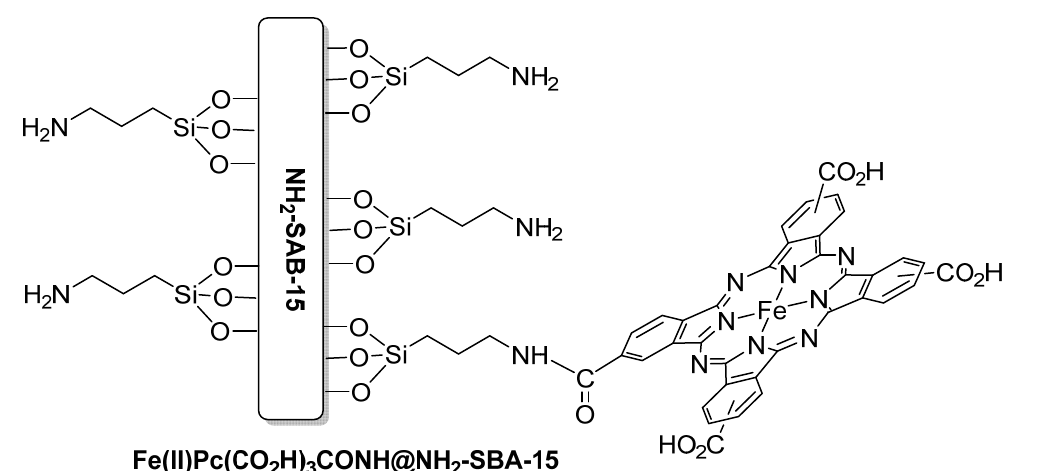
Figure 28. Schematic representation of iron(II) tetracarboxylphthalocyanine Fe(II)Pc(CO 2 H) 4 grafted onto amino-functionalized SBA-15 ( NH 2 -SBA-15 ) (adapted from [77]).